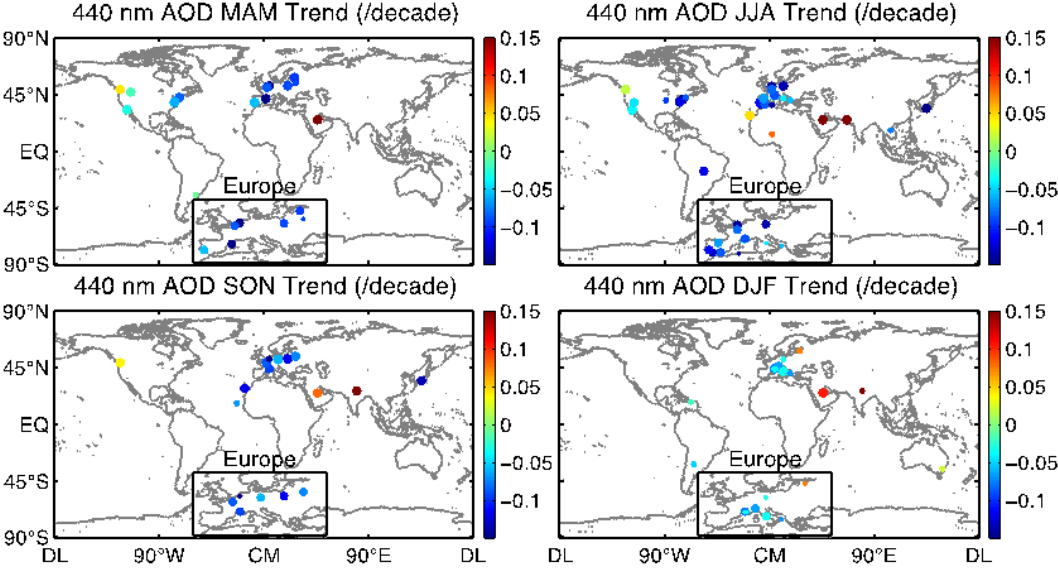
Figure 5. AOD trend maps for the four seasons. MAM: March-April-May; JJA: June-July-August; SON: September-October-November; DJF: December-January-February. Only statistically significant ( > 90%) trends are shown. The smaller dots indicate trends at 90% signif- icance, while larger dots indicate trends at 95% significance. The magnitude of the trend (decade − 1 ) is indicated by the color of the dots, following the color scale on the right.